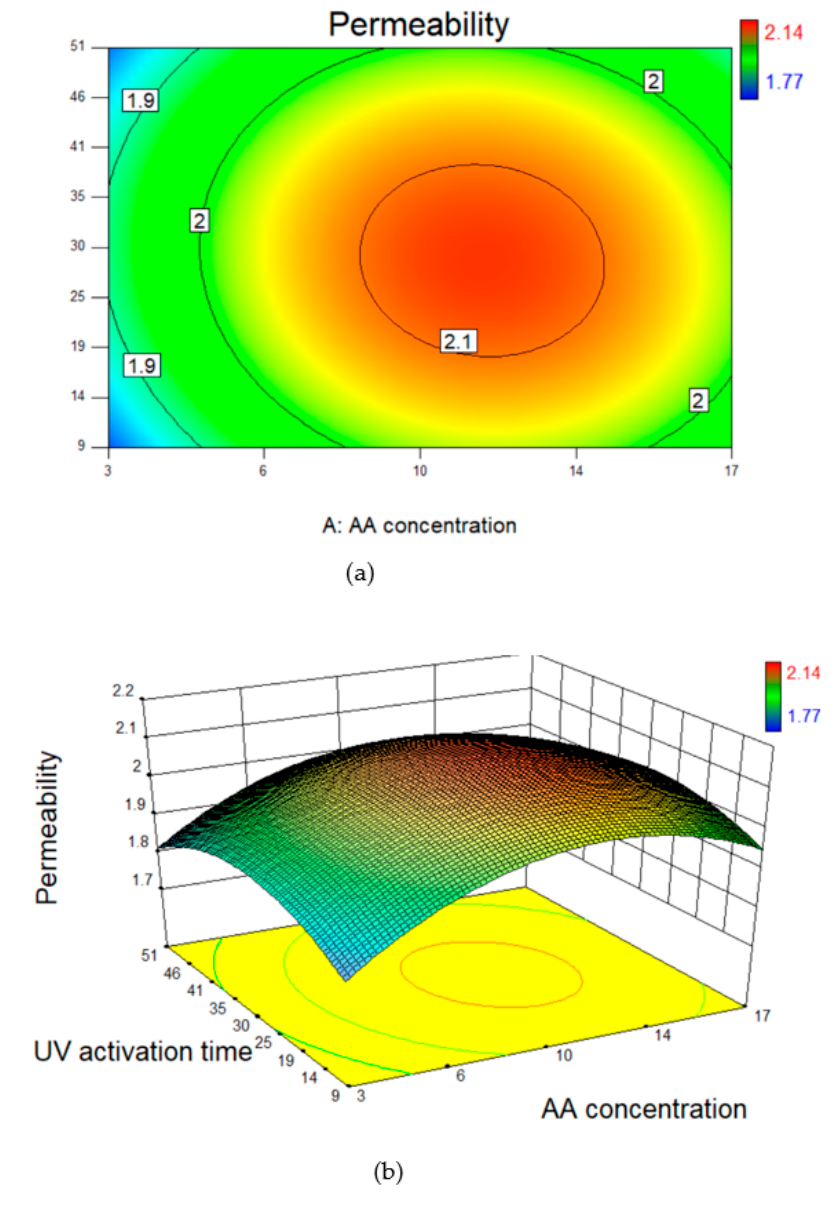
Figure 4. ( a ) Contour line map and ( b ) 3D surface plot for permeability as a function of acrylic acid concentration and UV activation time.